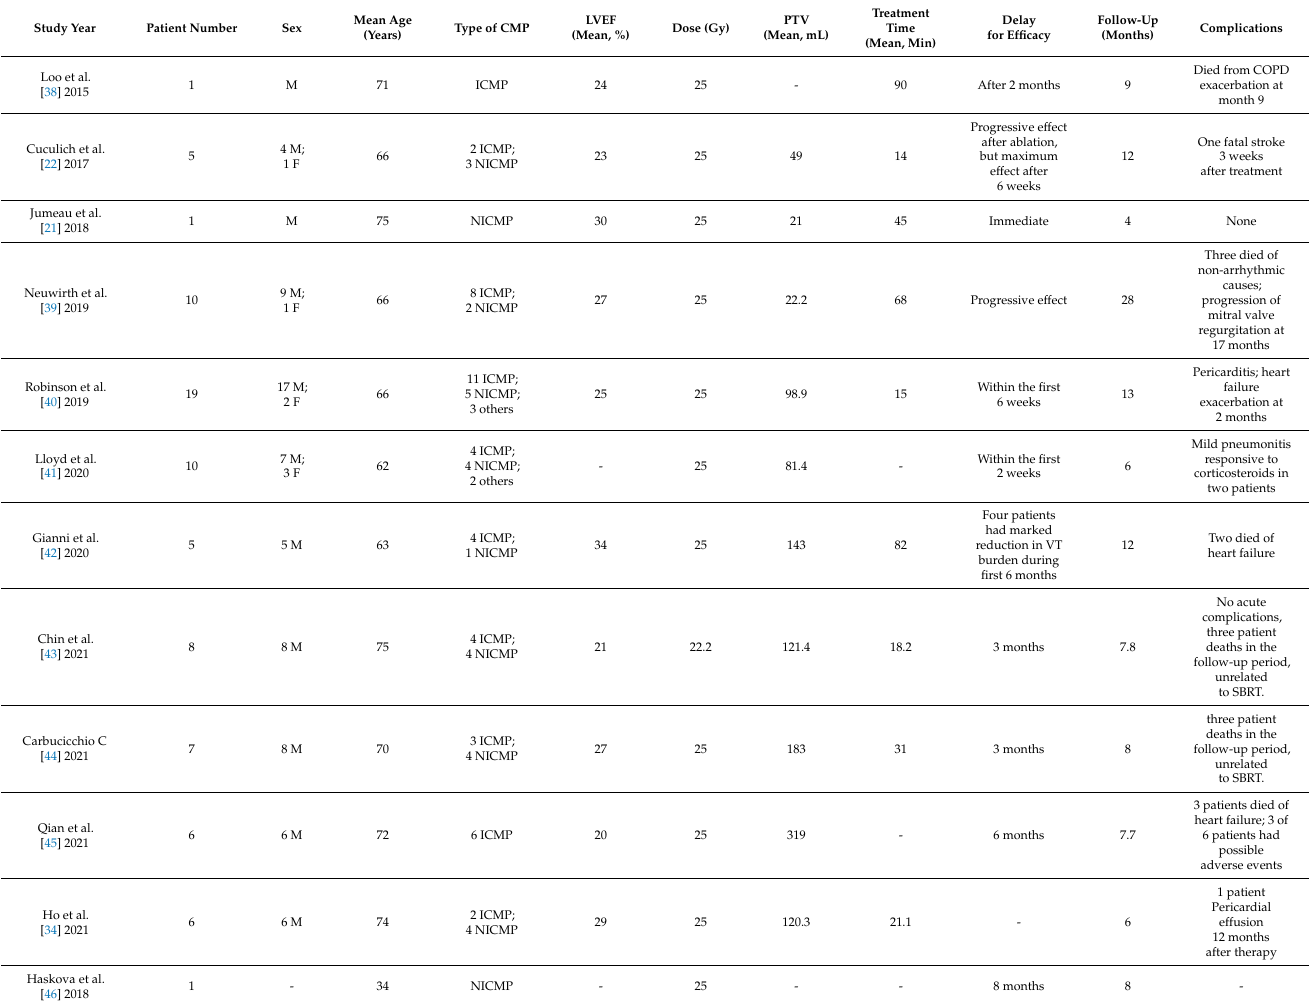
Table 1. Summary of the different studies on stereotactic radiotherapy for ventricular